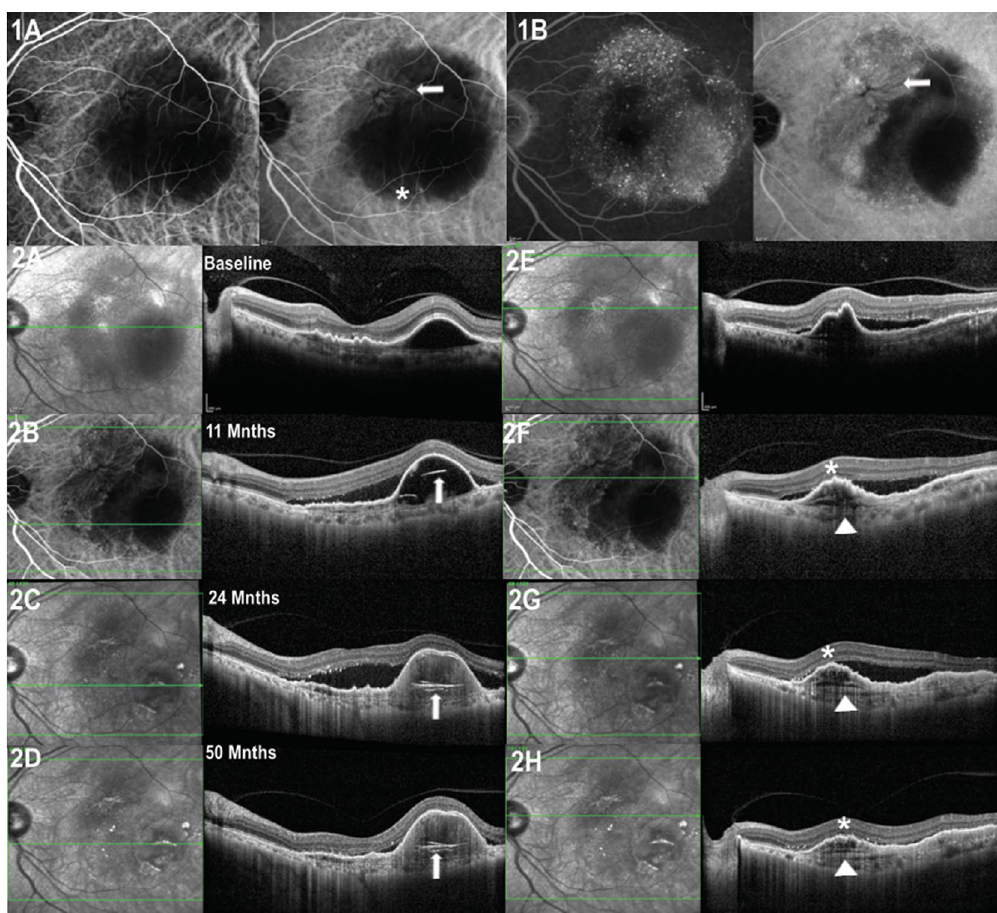
Figure 4. Left eye of a 77-year-old male with polypoidal choroidal vasculopathy (PCV) and multilayered pigment epithelial detachment secondary to chronic anti-VEGF therapy (s-MLPED). Baseline indocyanine green angiography (ICGA) shows a polyp (*) with a neovascular network (arrow) and large pigment epithelial detachment (PED; A ). Follow-up ICGA shows an increase in the size of the neovascular network arrow) ( B ). Serial cross-sectional optical coherence tomography (OCT) over a period of 50 months shows increasing multilayering (arrowheads) with irregular crenated retinal pigment epithelium (RPE; *) in the superior portion of PED ( F–H ) and concurrent occurrence and increase of hyperreflective laminated bodies (arrows) in the temporal portion of PED ( B–D ). Note the absence of choroidal